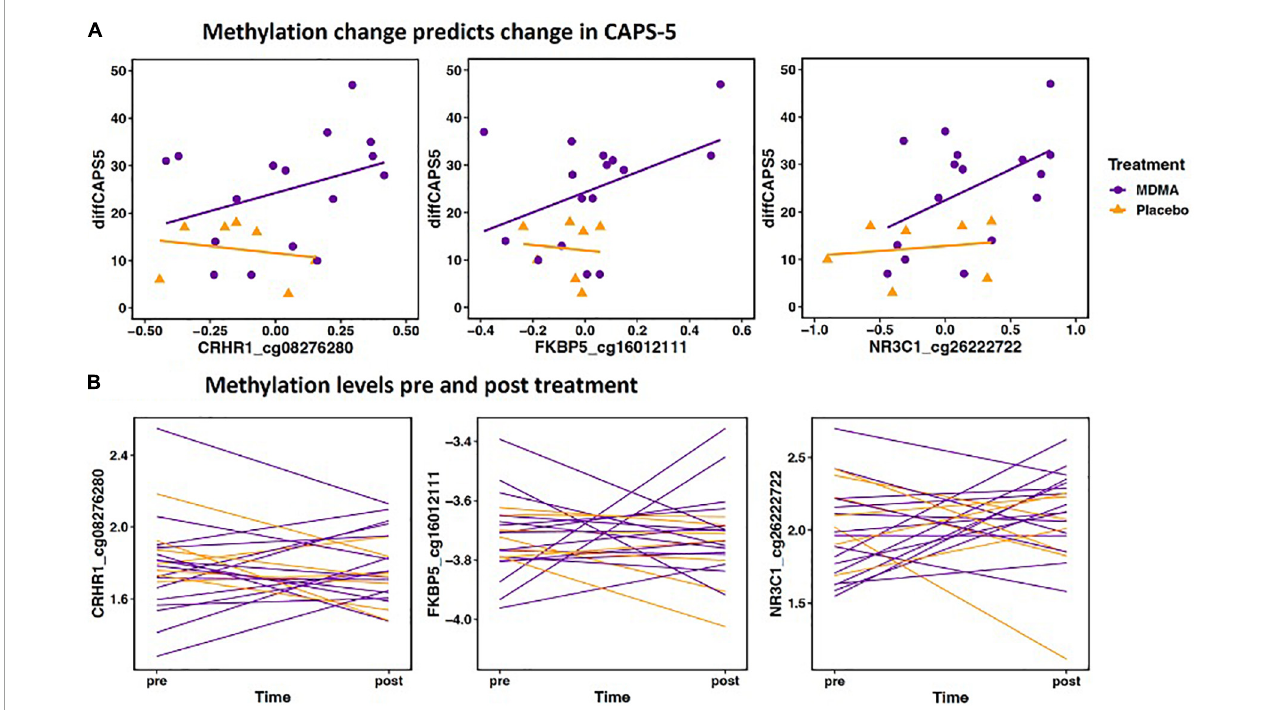
FIGURE2 (A) Methylation change predicts change in Clinician-Administered PTSD Scale for DSM-5 (CAPS-5). The scatterplot depicts the three (cid:49) change scores with the largest effect size from CRHR1 , FKBP5 , and NR3C1 (x axis) plotted with change scores in PTSD symptoms (CAPS-d). All three sites have a significant positive relationship, meaning decreased methylation is associated with decreased PTSD symptoms. The x axis change scores were calculated as post–treatment mVals–pre-treatment M-vals (positive values represent an increase in methylation). The y axis change scores were calculated as baseline–outcome (positive values represent a decrease in symptom severity). CRHR1 cg08276280 B = 42.12, p = 0.005; FKBP5 cg16012111 B = 32.52, p = 0.012; NR3C1 cg26222722 B = 19.32, p = 0.003. (B) Methylation levels from pre and post treatment (mVals). Figures highlight individual variation in methylation change across groups for the same three sites depicted above. M-values are plotted on the Y- axis; positive M-values represent more molecules are methylated than unmethylated, while negative M-values mean the opposite (20).